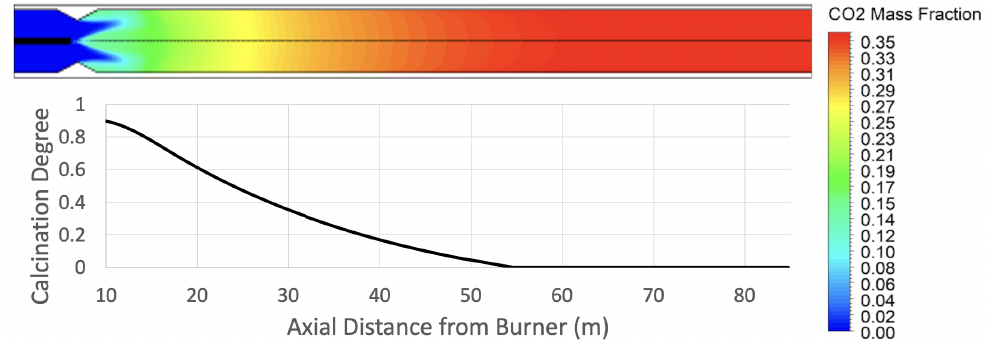
Figure 8. CO 2 mass fraction and degree of calcination for a dry